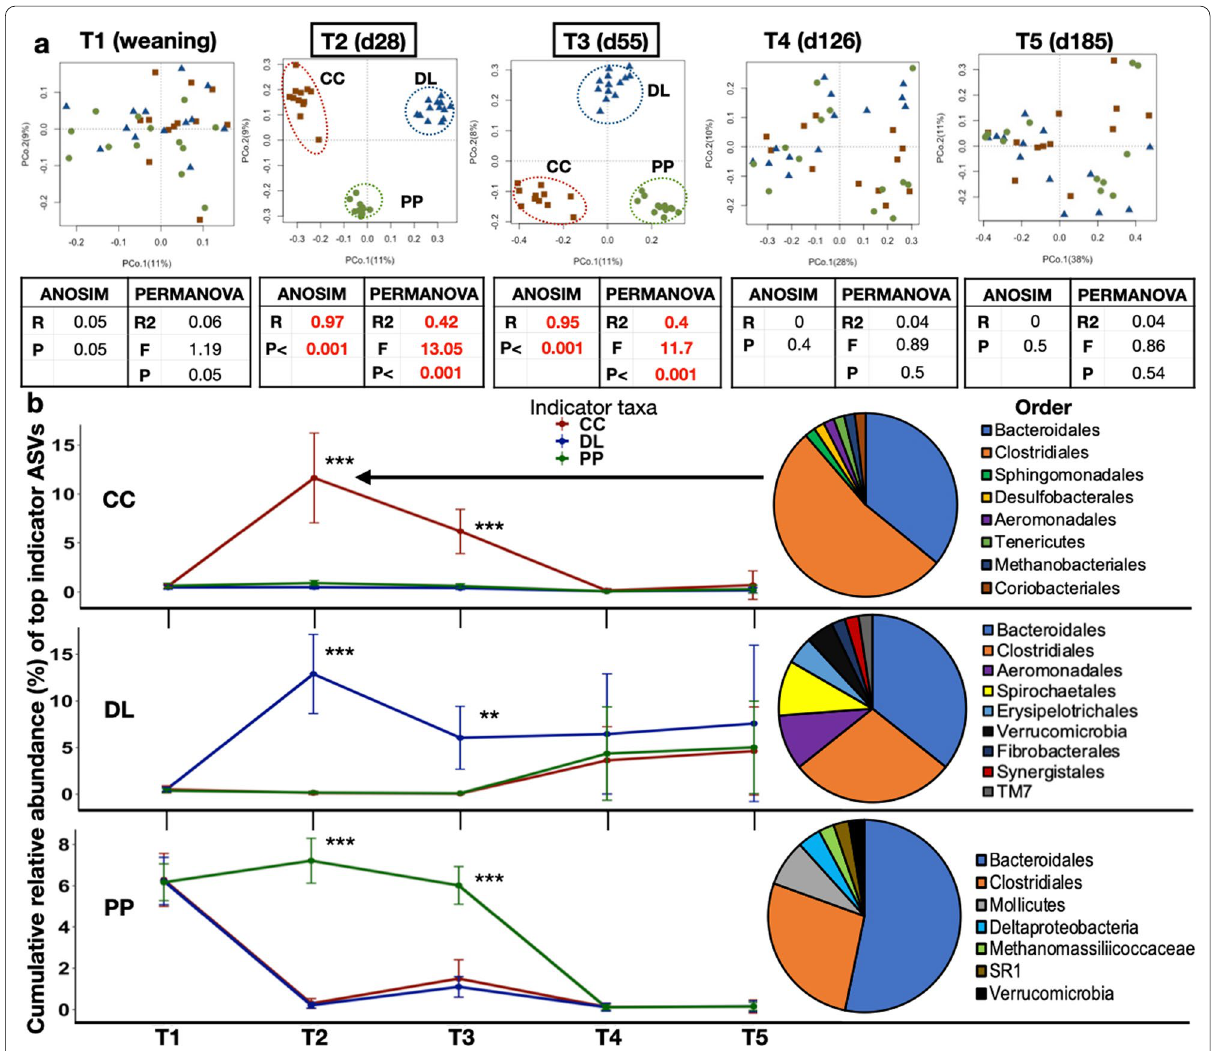
Fig. 4 Rumen bacterial composition and abundance of indicator taxa at weaning (T1), backgrounding (T2–T3), and finishing (T4–T5). a Principal coordinate analysis (PCoA, Bray–Curtis distances) showing bacterial compositional differences at weaning, BKG and finishing. ANOSIM and PERMANOVA test results, along with their statistics are displayed below each PCoA plot. b Cumulative abundance of indicator ASVs, distinguishing each BKG system, at weaning, BKG and finishing. The line plots show how the cumulative abundance of these indicator ASVs peaks during BKG (T2). The pies show the taxonomic affiliation, at the order level, of the indicator ASVs. Asterisks show significant differences in the abundance of indicator taxa between groups based on Kruskal–Wallis tests adjusted for multiple comparisons (**P < 0.001, ***P < 0.0001). Dry lot (DL); cover crop (CC) and perennial pasture